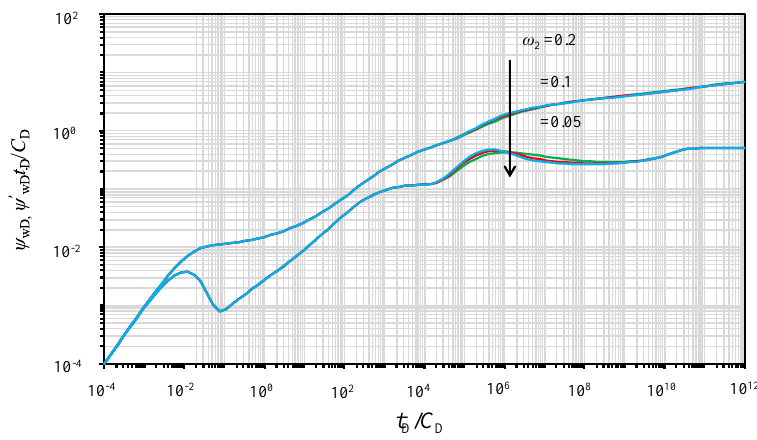
Figure 14. Effect of the storativity ratio of outer region on the PPR and PPD.